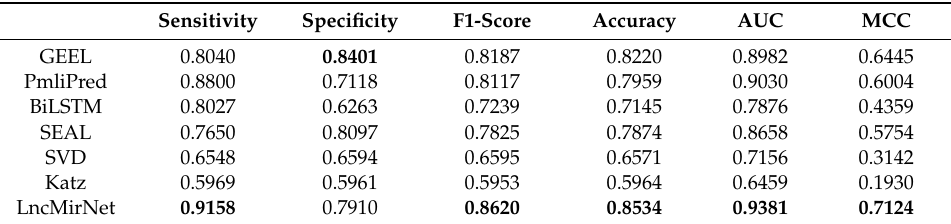
Table 2. The results of the six methods by five-fold cross validation on all data.